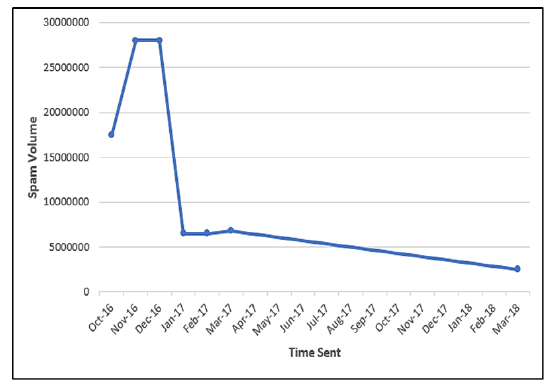
Figure 1. The volume of Spam Emails from 2016